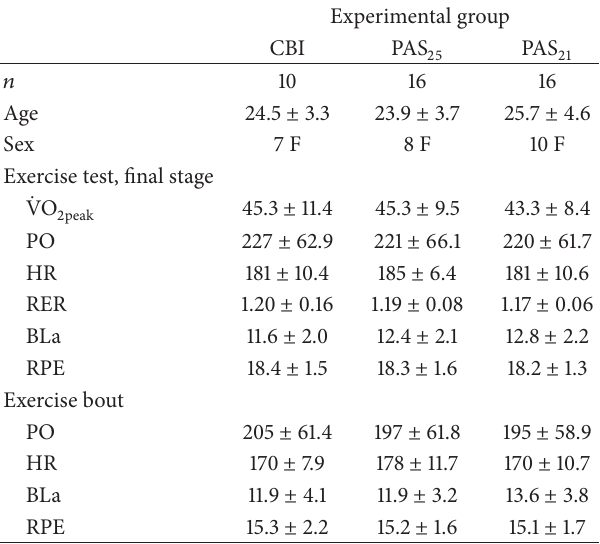
Table 1: Participant characteristics. Experimental